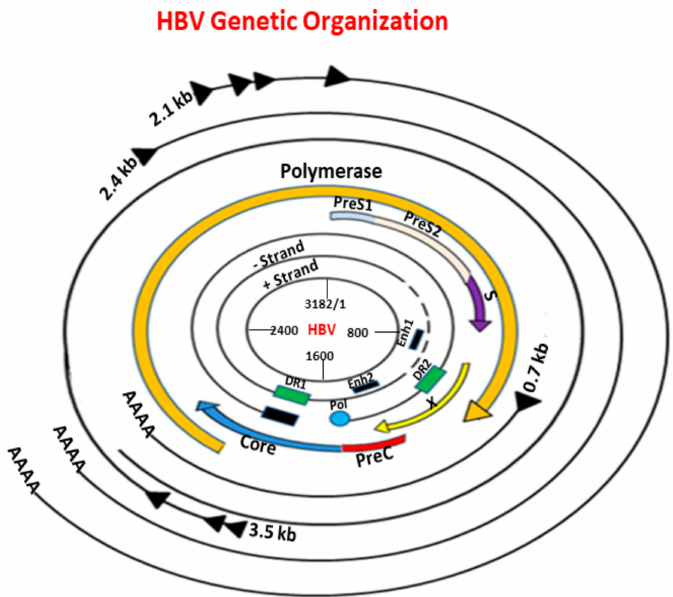
Figure 1. Genetic organization of the hepatitis B virus (HBV). HBV contains a small, partially double-stranded DNA (dsDNA) of about 3.2 kb. The main four open reading frames (ORFs) are shown: precore / core (preC / C) that encodes the e antigen (HBeAg) and core protein (HBcAg), P for polymerase (reverse transcriptase), Pre-surface / surface (preS / S) including preS1 / preS2 / S for surface proteins (small (S), middle (M), and large (L)), and X for transcriptional trans-activator protein. The genome contains four promoters, two enhancer regions (Enh1, Enh2), and two direct repeats (DR1, DR2). The outer lines represent the di ff erent classes of HBV mRNA transcripts.